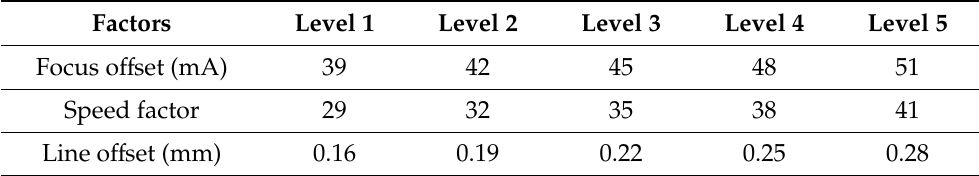
Table 2. Factors and di ff erent levels used for experimental design.